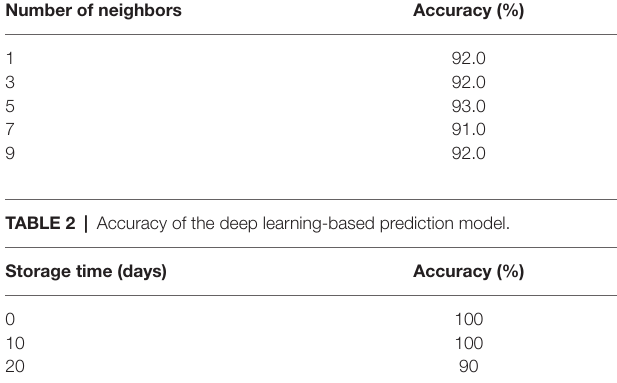
TABLE 1 | Accuracy of the KNN-based prediction model using different number of neighbors.